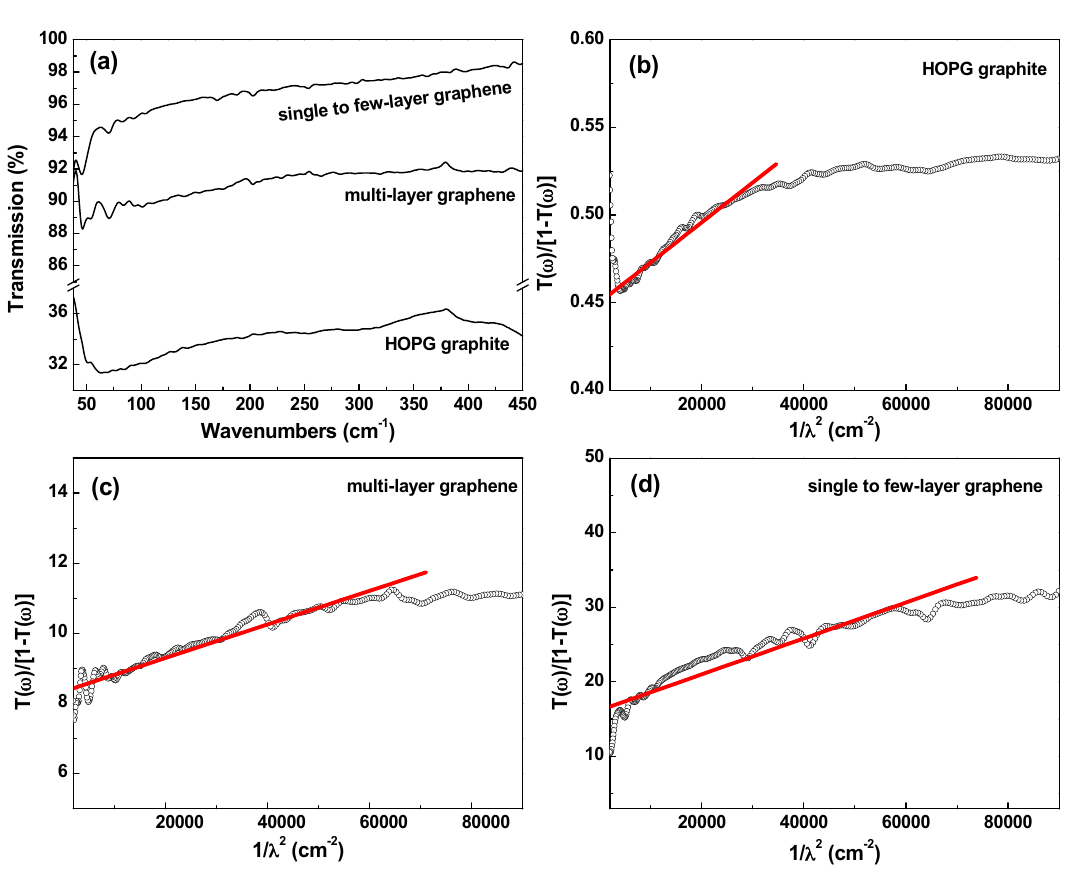
Figure 4. ( a ) Far-IR transmission results of three representative samples, as labeled; ( b – d ) Representative fits demonstrating linear dependence of the ratio of transmittance, T( ω ), to [1 − T( ω )] as a function of 1/ λ 2 for the samples in Figure ( a ).